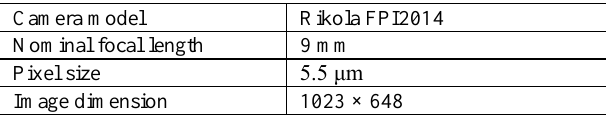
Table 1. Technical details.